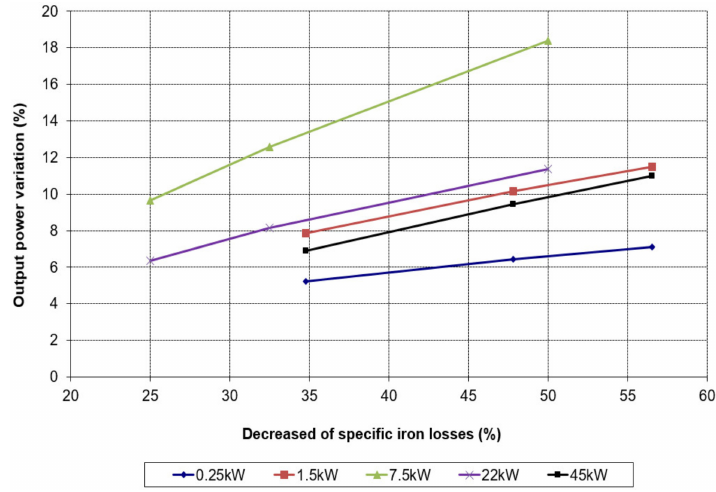
Figure 10. Output power variation versus decreased of specific iron losses in all the motors.